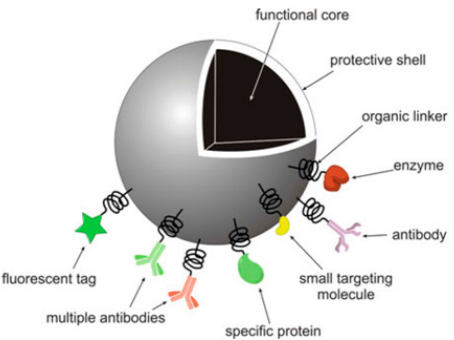
Figure 1. A model design of an inorganic nanoparticle (NP) functionalized with biomolecules for biomedical applications [6]. Reproduced with copyright permission from Springer Nature, 2010.